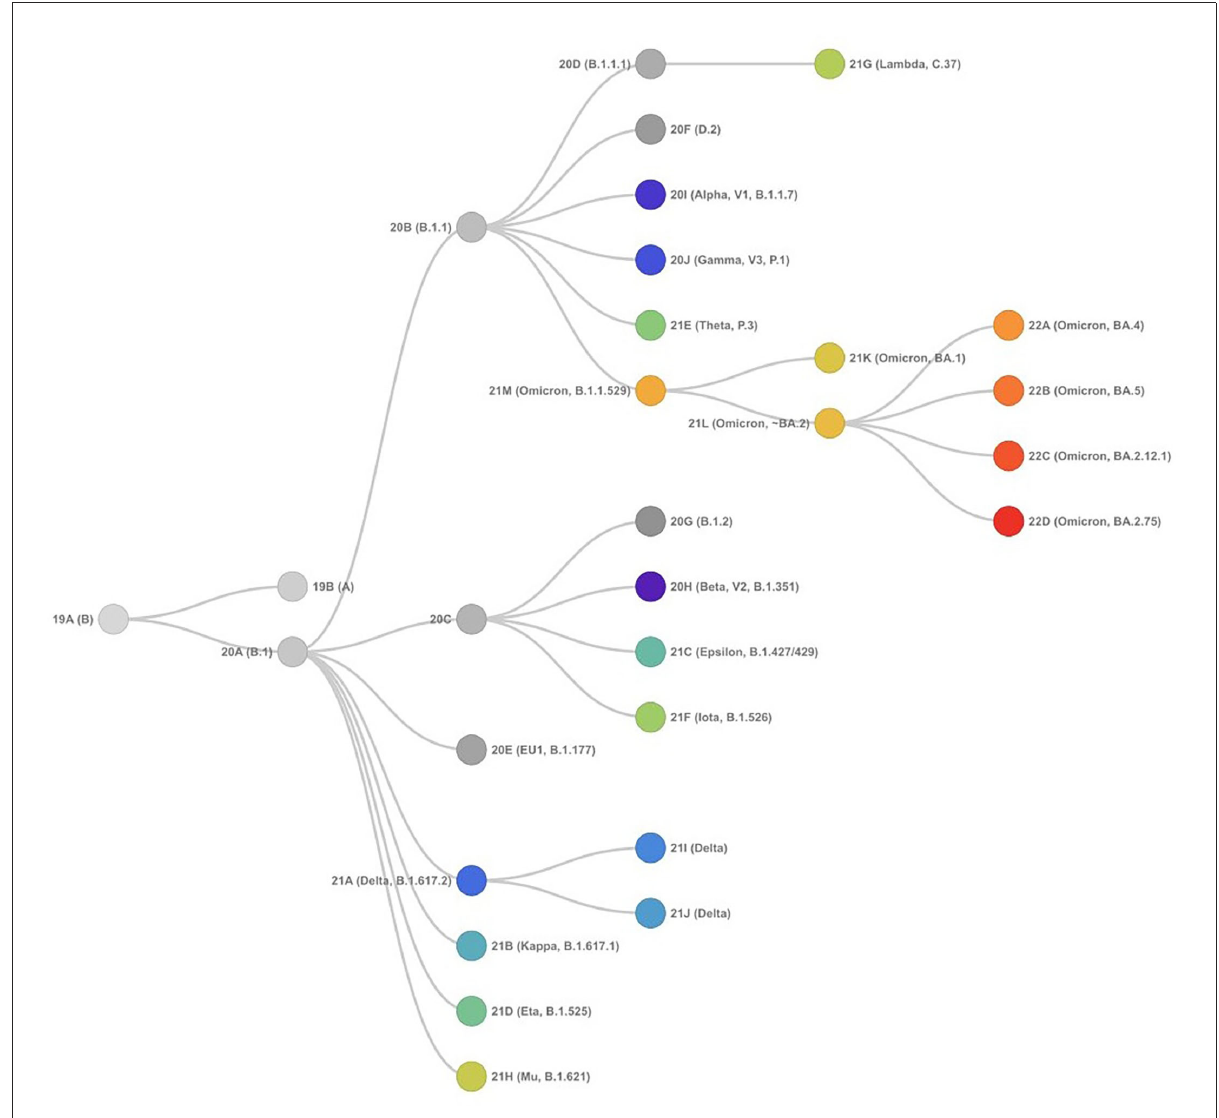
FIGURE3 Phylogenetic relationships of SARS-CoV-2 clades, as defined by Nextstrain (as of September 15, 2022) showing evolutionary relationships of SARS-CoV-2 viruses from the ongoing COVID-19 pandemic. The phylogeny is rooted relative to early samples from